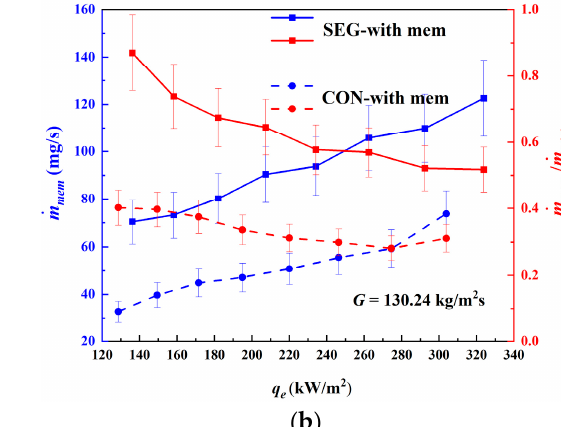
Figure 15. Vapor venting characteristics of membranes in the continuous and segmented heat sinks: ( a ) G = 80.48 kg m − 2 s − 1 ; ( b ) G = 130.24 kg m − 2 s − 1 . ( a ) G = 80.48 kg m − 2 s − 1 ; ( b ) G = 130.24 kg m − 2 s − 1